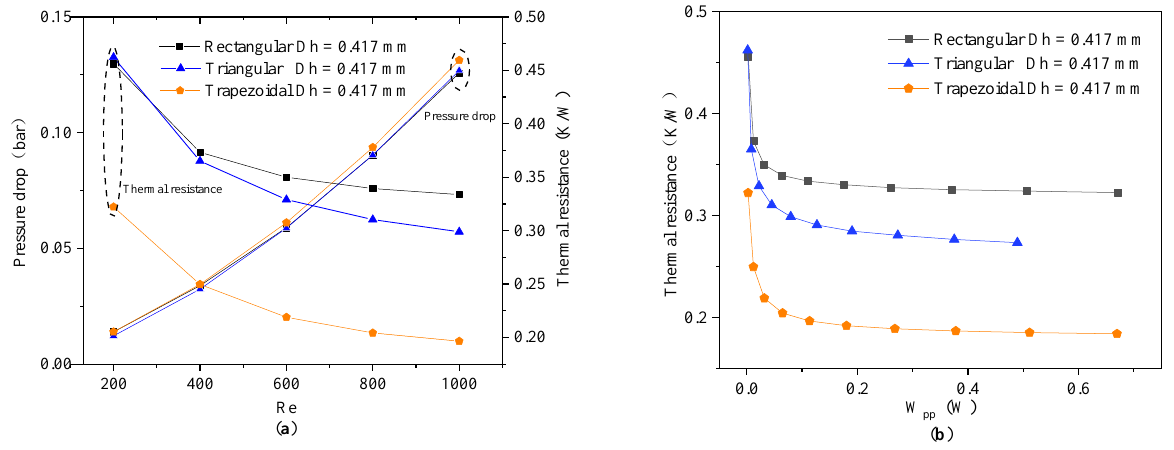
Figure 11. The variation of thermal resistance and pressure drop for different Reynolds numbers ( a ). Thermal resistance under the different W pp values ( b ).